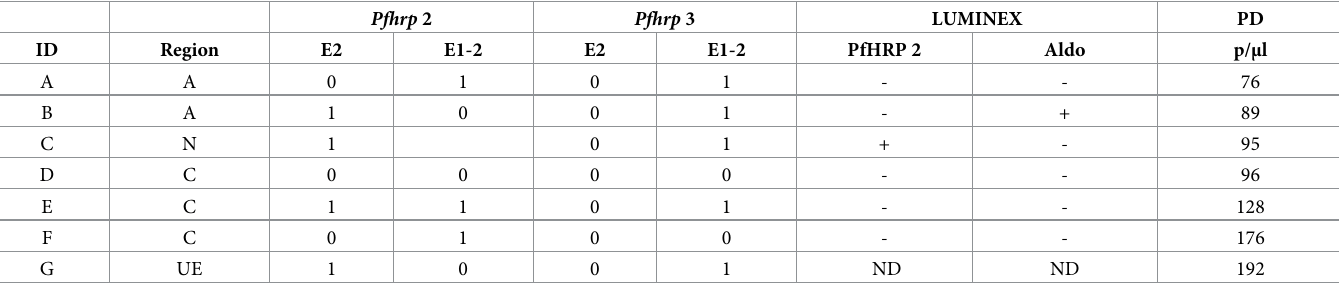
Table 3. Distribution of parasites with Pfhrp 2/3 gene deletions in samples containing less than 200 parasites/ μ